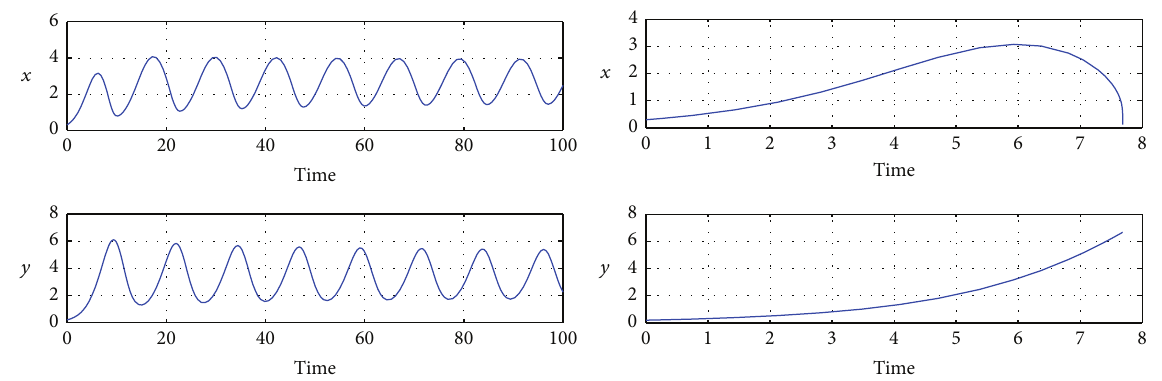
Figure 5: When 𝜏 = 2.9 > 𝜏 0 ≐ 2.8015 , prey species 𝑥 and predator species 𝑦 coexist; when 𝜏 = 5 > 𝜏 0 ≐ 2.8015 , prey species 𝑥 goes to